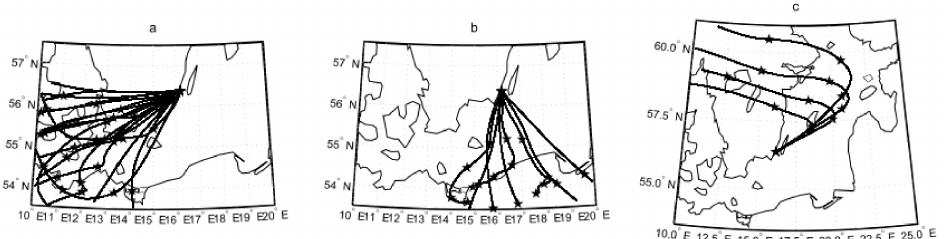
Figure 4. The 48-h back trajectories arriving at the island of Garpen every 6 h, divided according to the three wind sectors: the near-coastal sector ( a ), the long-fetch sector ( b ), and the Kalmar Strait sector ( c ). Stars denote every 12th hour along the